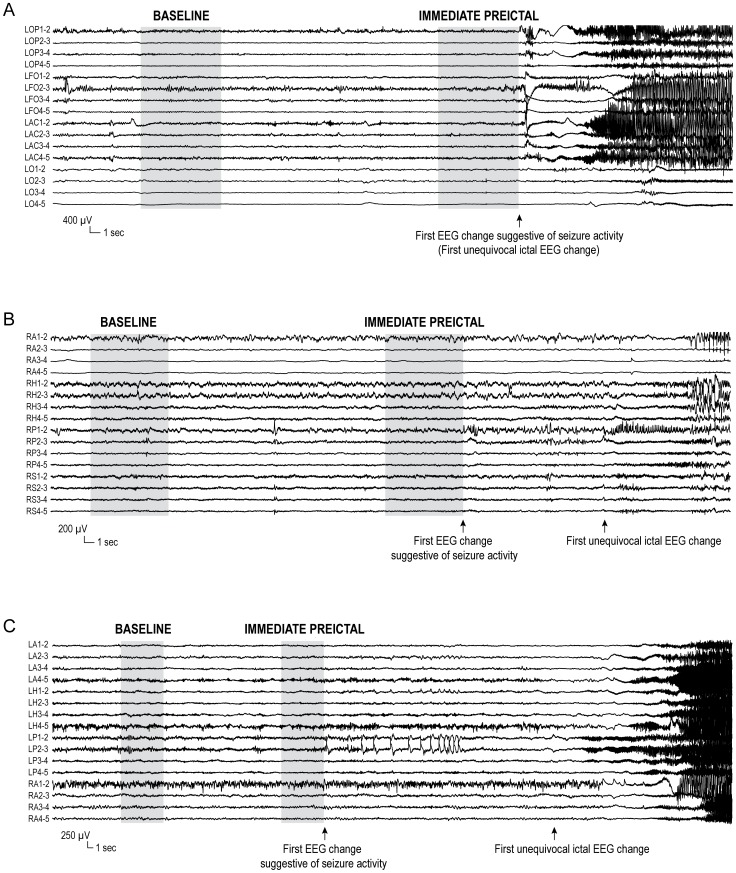
Definition of the “first EEG change suggestive of seizure activity”.This was the earliest potential ictal EEG sign, and could coincide with or precede the first unequivocal ictal EEG change. (A) Seizure recorded in a patient with a left centro-parietal porencephalic cyst, in which the sudden onset of polyspike/fast activity at LOP and LFO (arrow) was not preceded by any ictal-like EEG change. (B) Seizure recorded in a patient with right posterior quadrant periventricular nodular heterotopia, in which the first unequivocal ictal EEG change, a build-up of polyspikes at RP1-2 and 2-3 (arrow), was preceded 14 seconds earlier by the insidious appearance of polymorphic slowing with intermingled spikes at the same contacts (first EEG change suggestive of seizure activity, arrow). (C) Seizure recorded in a patient with left mesial temporal atrophy, in which the first unequivocal ictal EEG change, low-voltage fast activity at LP1-2 and 2-3 (arrow), was preceded 43 seconds earlier by the appearance of a run of repetitive sharp waves at the same contacts, which was not followed by a return to the usual EEG background (first EEG change suggestive of seizure activity, arrow). LOP = left frontal operculum; LFO = left orbito-frontal region; LAC =  left anterior cingulate gyrus; LO = left occipito-parietal region; RA = right amygdala; RH = right hippocampus; RP = heterotopic nodule in the right temporo-occipital quadrant; RS = heterotopic nodule in the right inferior parietal region; LA = left amygdala; LH = left hippocampus; LP = left posterior hippocampus.